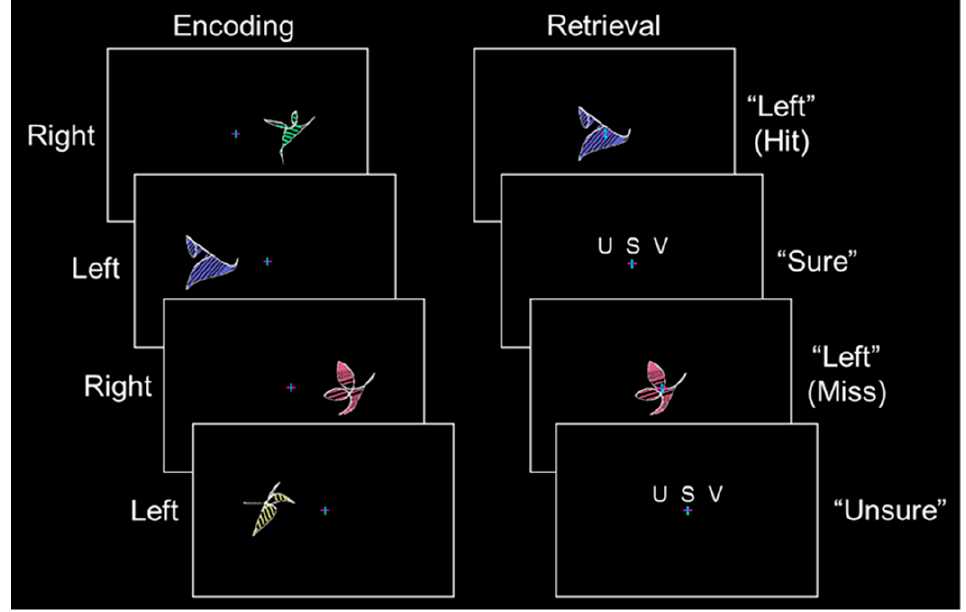
Figure 2. Experimental paradigm. Left , during encoding, participants viewed abstract shapes to the left or right of fixation (item types are shown to the left). Right , during retrieval, old items from encoding were presented at fixation and participants classified each shape as previously on the “left” or “right” followed by an “unsure”–“sure”–“very sure” confidence rating (possible responses and corresponding event types are shown to the right).